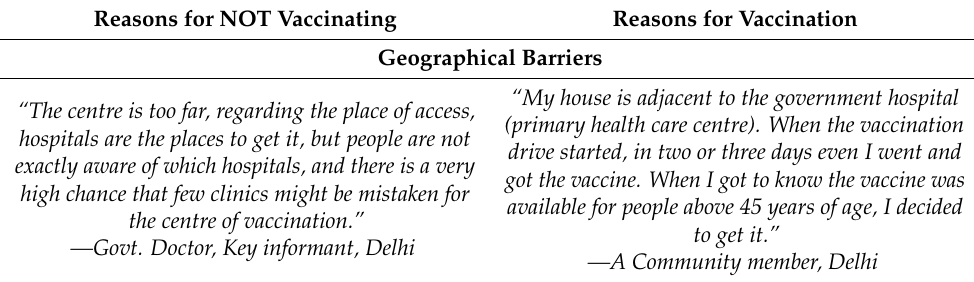
Table 9. Description of theme geographical barrier with verbatim.